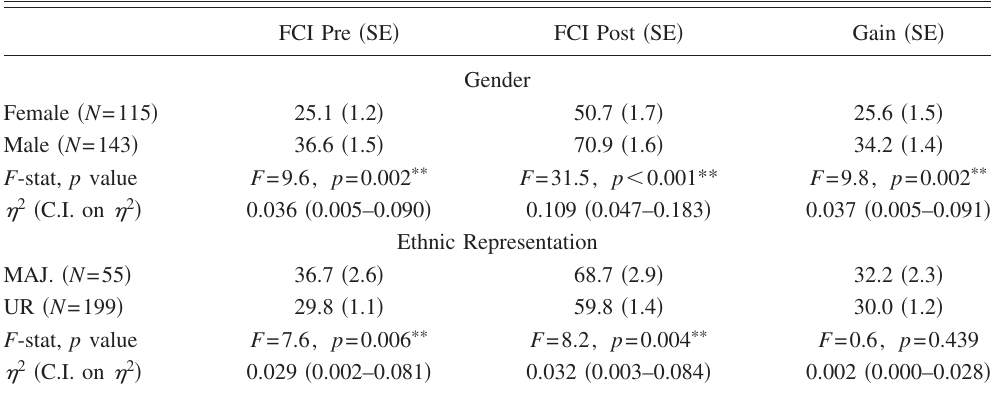
TABLE II. Analysis of Variance on Students in MI’s FCI Scores.